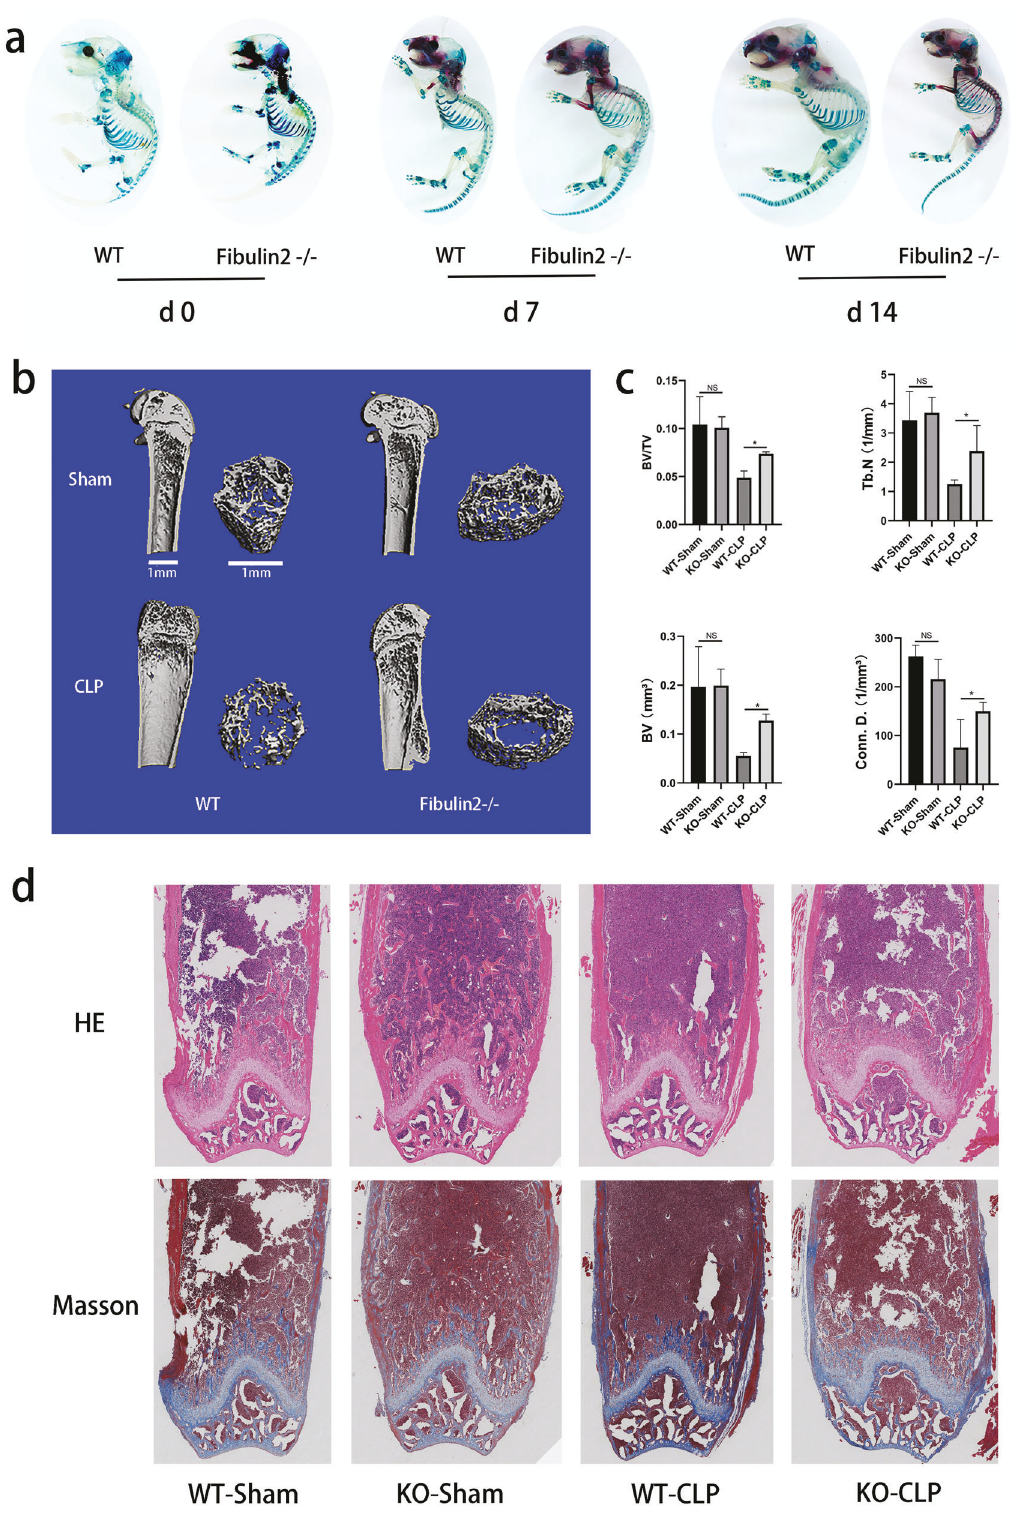
Fig. 2 Fibulin2 knockout accelerates bone formation during early skeletal development and inhibits in fl ammatory bone resorption after cecal ligation and puncture surgery in mice. a Fibulin2 knockout (KO) neonatal mice and wild-type (WT) mice from the same litter were used to stain whole skeletal tissue with alizarin red/Alcian blue, and the staining intensity was assessed after 0, 7 or 14 days. Mineralized bone was stained red, and cartilage was stained blue. b Trabeculae in the area within 1 cm of the proximal end of the growth plate in femurs. Trabecular number was determined by microcomputed tomography (micro-CT). c Quanti fi cation of the micro-CT results. Bone volume (BV), bone volume/tissue volume (BV/TV), trabecular bone number (Tb. N), and connectivity density (Conn. D.). (NS not signi fi cant; * P < 0.05, n ≥ 3). d HE-stained and Masson ’ s trichrome-stained femurs. (CLP cecal ligation and puncture). All femurs were harvested 28 days after